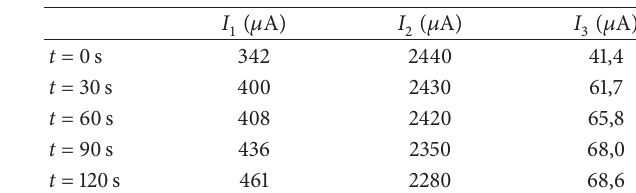
Table 1: Variation of intensity with the time of immersion of the electrode in aqueous phase at pH 1.5, varied from 0 to 120 s with a step of 30s. Each voltammogram was recorded by imposing a new film on the electrode